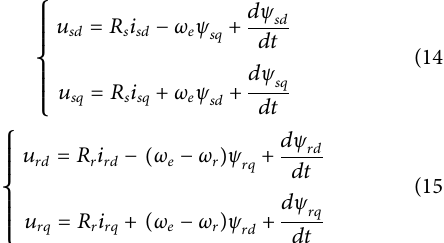
FIGURE 5 Units in a